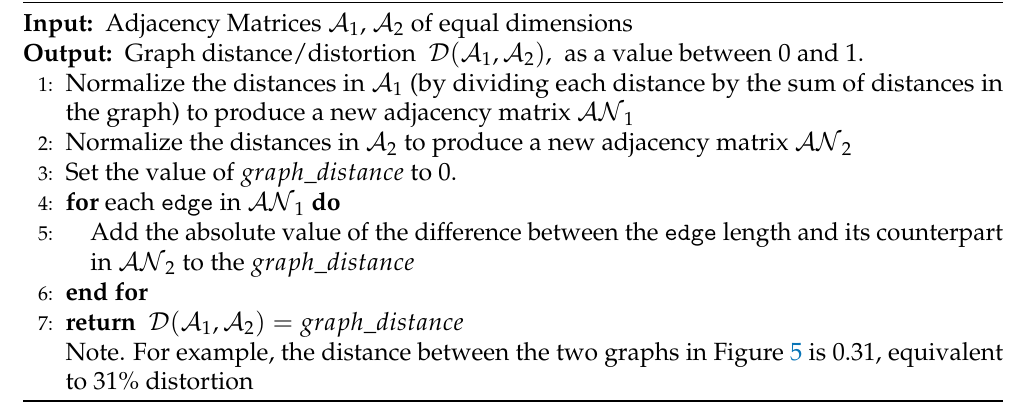
Algorithm 2 Distance or Percentage Distortion between Two Complete Graphs (cliques of the same size).